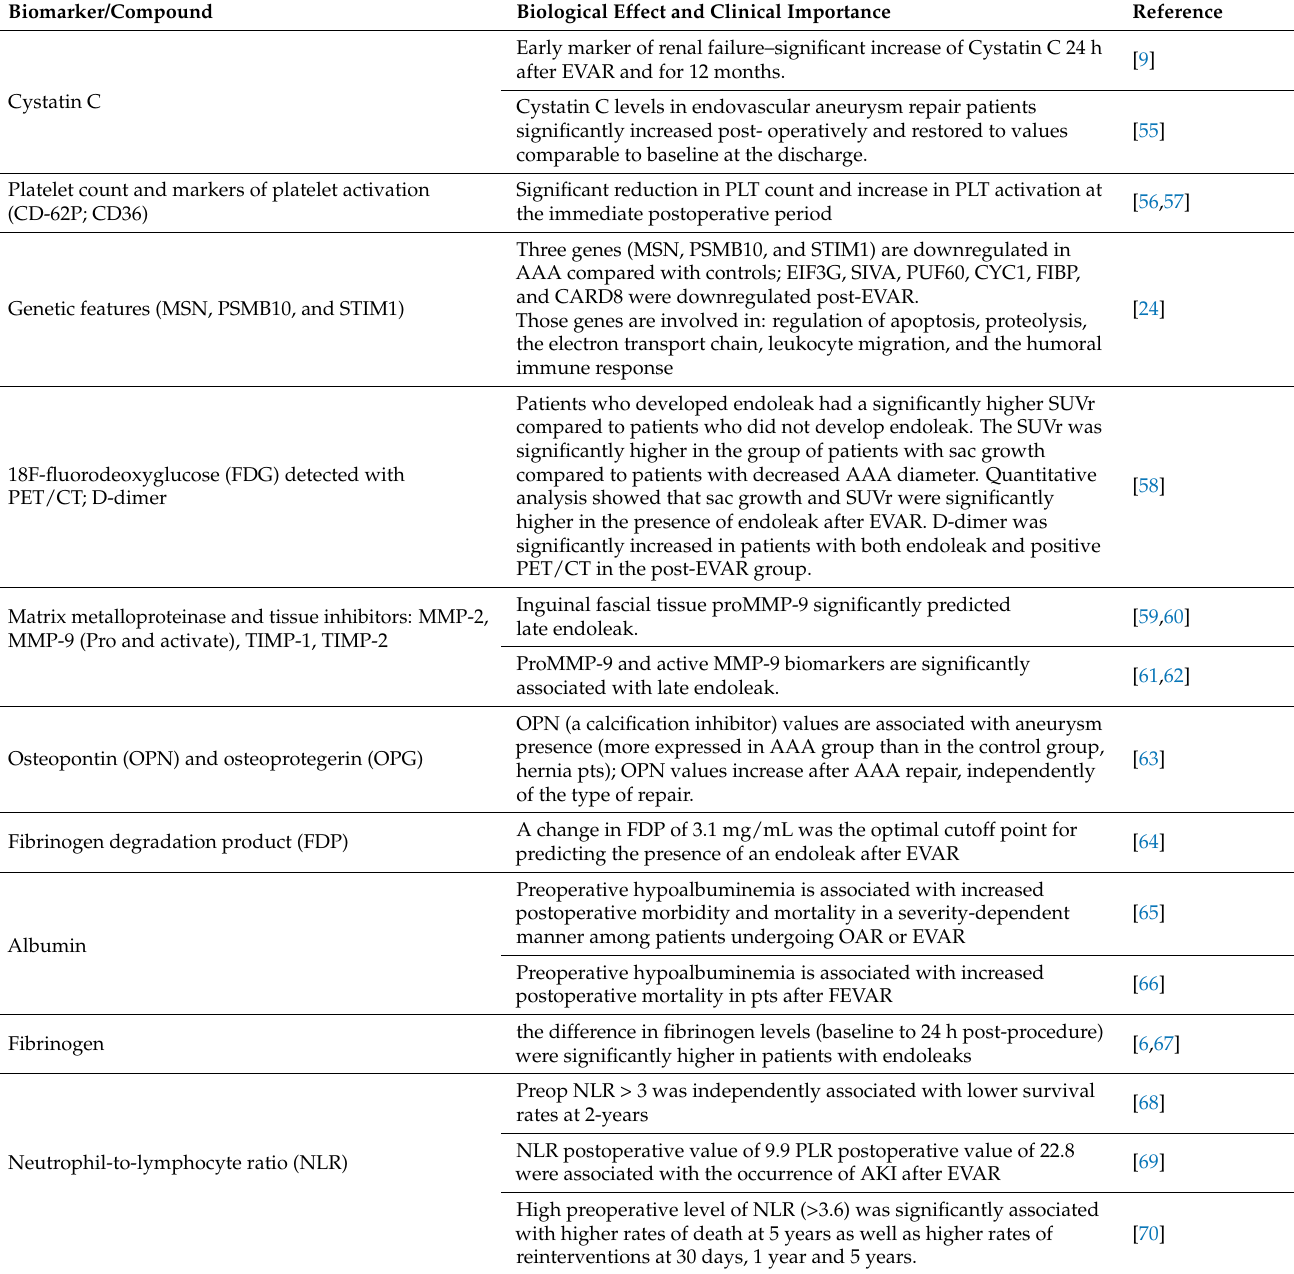
Table 2. Biomarkers and compounds in EVAR (treated